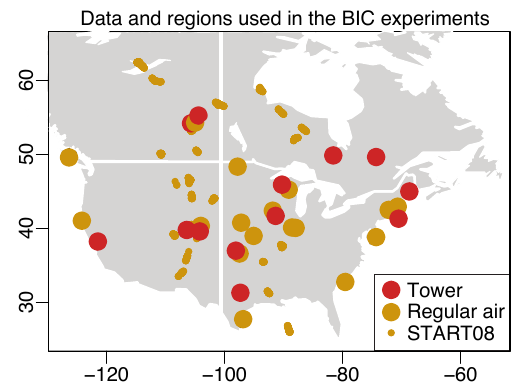
Figure 2. The US and Canadian atmospheric methane observation network for 2007–2008 (14703 total observations). Small yellow dots indicate observations from the START08 measurement cam- paign (Pan et al., 2010). Larger dots indicate tower and aircraft sites with regular observations over the 2-year period (Andrews et al., 2014). The grey background delineates the four regions used in the synthetic data experiments (Sect.